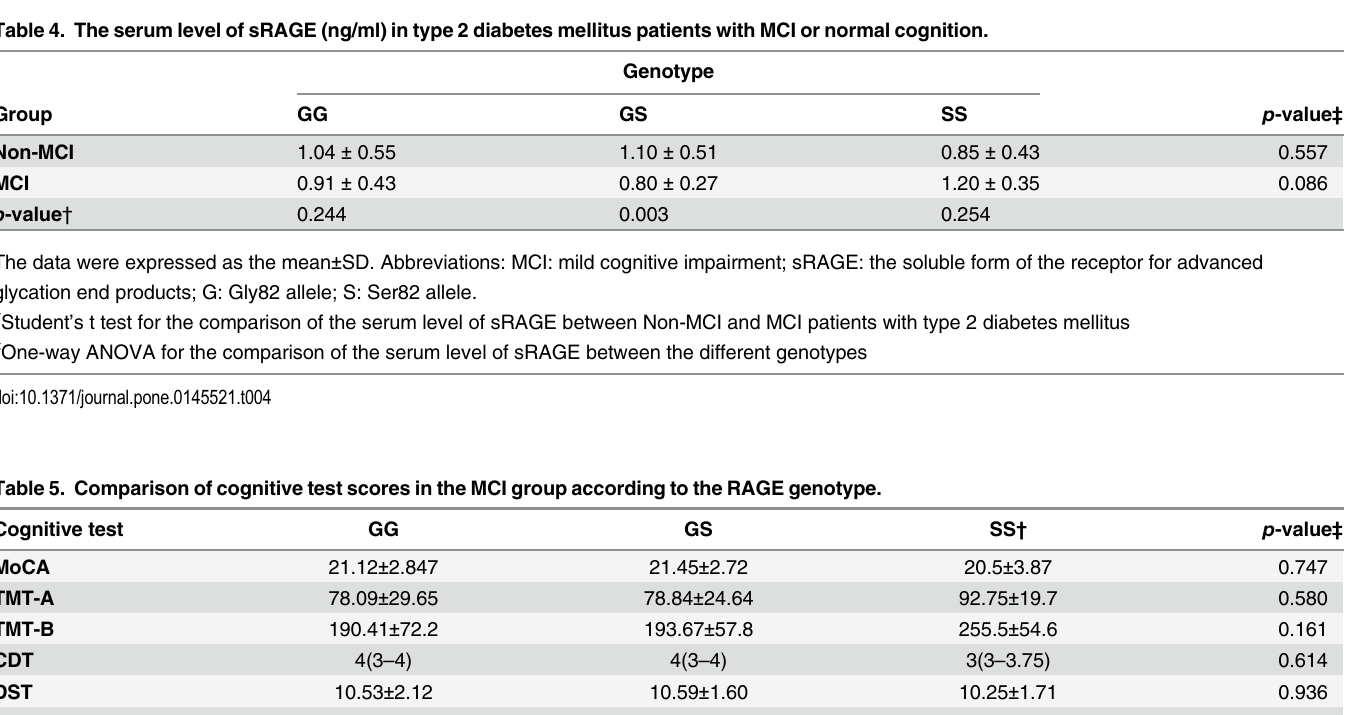
Table 4. The serum level of sRAGE (ng/ml) in type 2 diabetes mellitus patients with MCI or normal cognition.